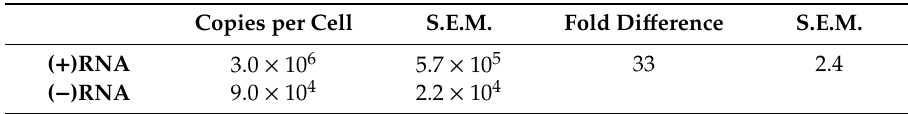
Figure 3. Strand-specific bDNA FISH in ZIKV. Vero cells were infected with ZIKV at a multiplicity of infection (MOI) of 0.1. After 48 h, the cells were fixed and probed for ( − )RNA (red) and ( + )RNA (green). Finally, nuclei were stained with DAPI. Cells were imaged on a Leica SP8 confocal microscope using a 63 × oil-immersion objective. Representative images are shown for sequential staining approaches: ( A ) ( + )RNA only; ( B ) ( − )RNA only; ( C ) cells were stained first for ( + )RNA, then for ( − )RNA; ( D ) cells were stained first for ( − )RNA, then for ( + )RNA. ( E ) and ( F ) Uninfected cells were stained for ( + )RNA and ( − )RNA as indicated. For 100–250 cells per condition, ( G ) ( − )RNA foci were counted, ( H ) ( − )RNA fluorescence intensity was measured, ( I ) area of ( − )RNA foci was measured, and ( J ) ( + )RNA fluorescence intensity was measured. Error bars represent standard error of the mean for two independent experiments. Significances of di ff erences between staining methods were calculated using one-way ANOVA and Dunnett’s post-test for multiple comparisons. Di ff erences were not significant unless otherwise indicated. *, p ≤ 0.05; ***, p ≤ 0.001. AU, arbitrary units; px, pixels. Scale bars represent 10 µ m. Table 2. Copies per cell of ZIKV RNA, estimated by strand specific RT-qPCR from three independent experiments. S.E.M., standard error of the